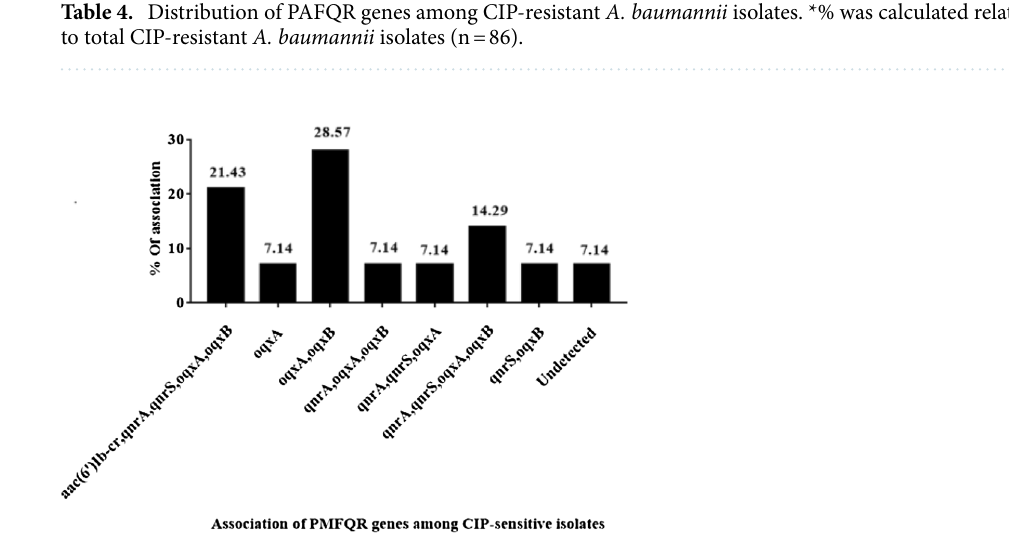
Figure 5. Distribution of PAFQR genes among CIP-sensitive A. baumannii